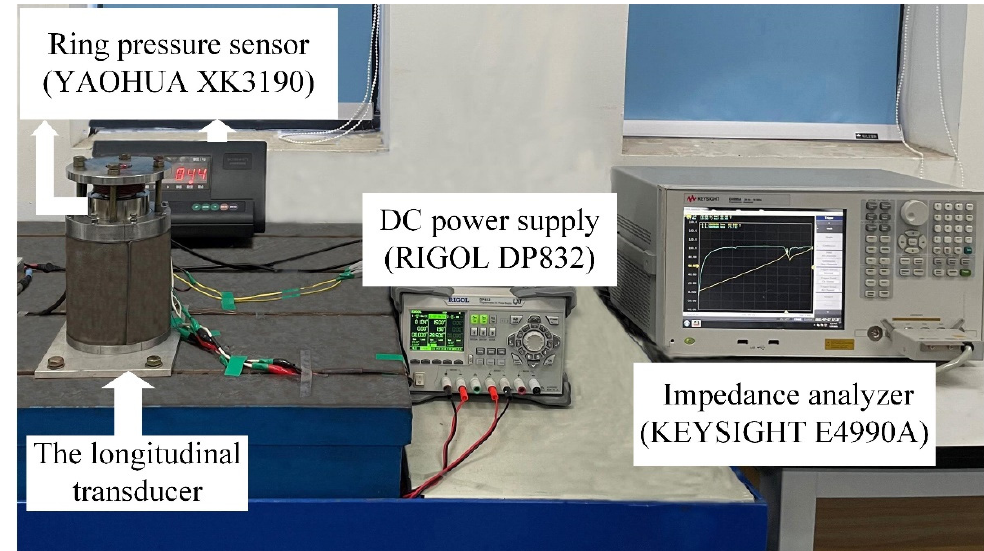
Figure 10. The impedance/phase measurement device.